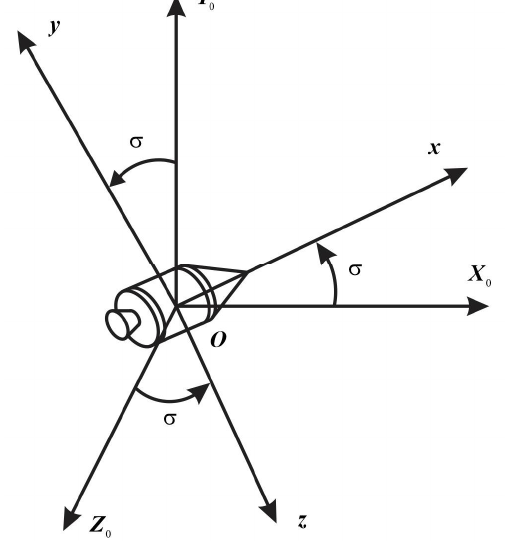
Figure 1. The link between local frame and body frame.